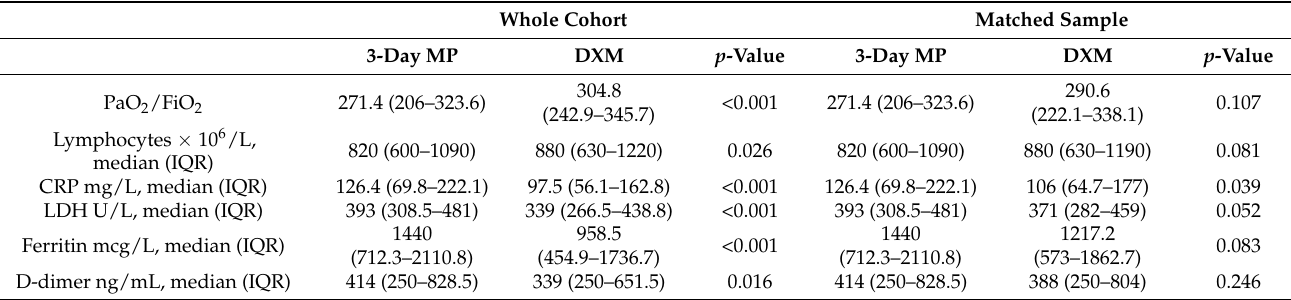
Table 3. Comparison of laboratory tests upon admission between groups.